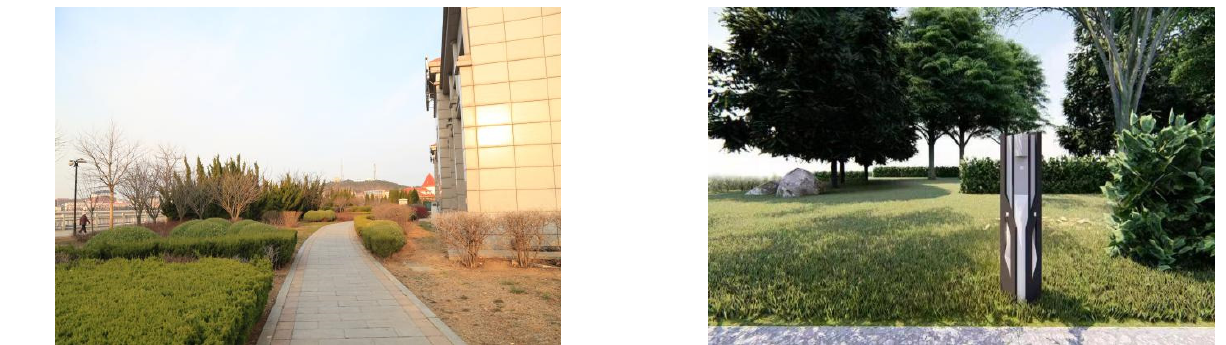
Figure 1. The diagram of park sidewalk scene and lighting layout effects.